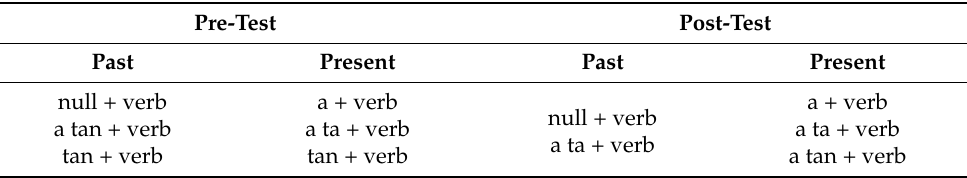
Table 8. Particle combination produced by heritage speakers of Palenquero in the present and past tense/pre-and